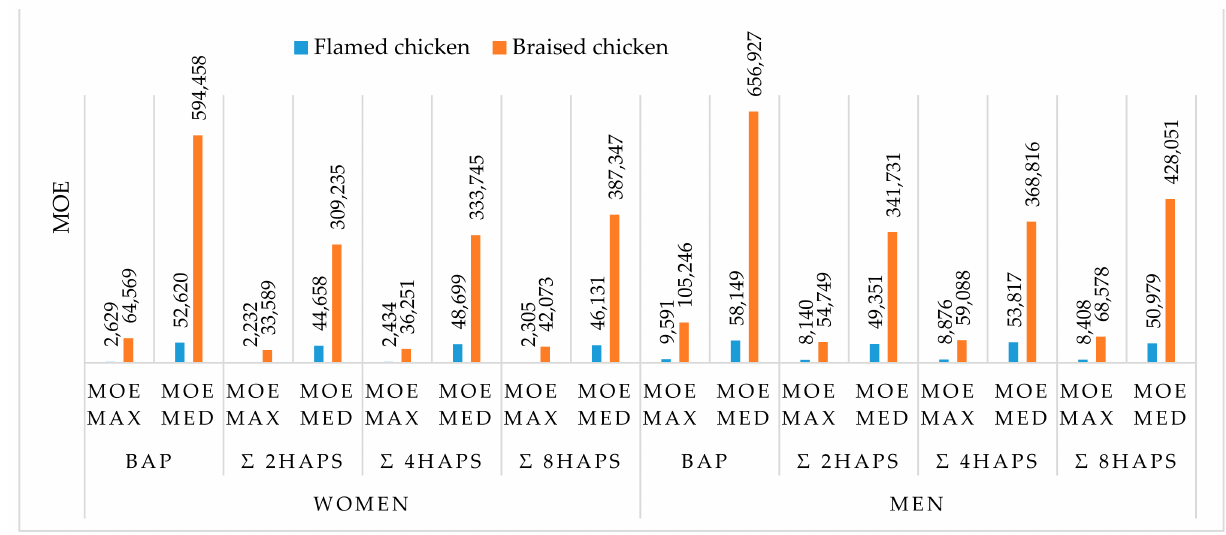
Figure 2. Margins of exposure for BaP, 2PAHs, 4PAHs and